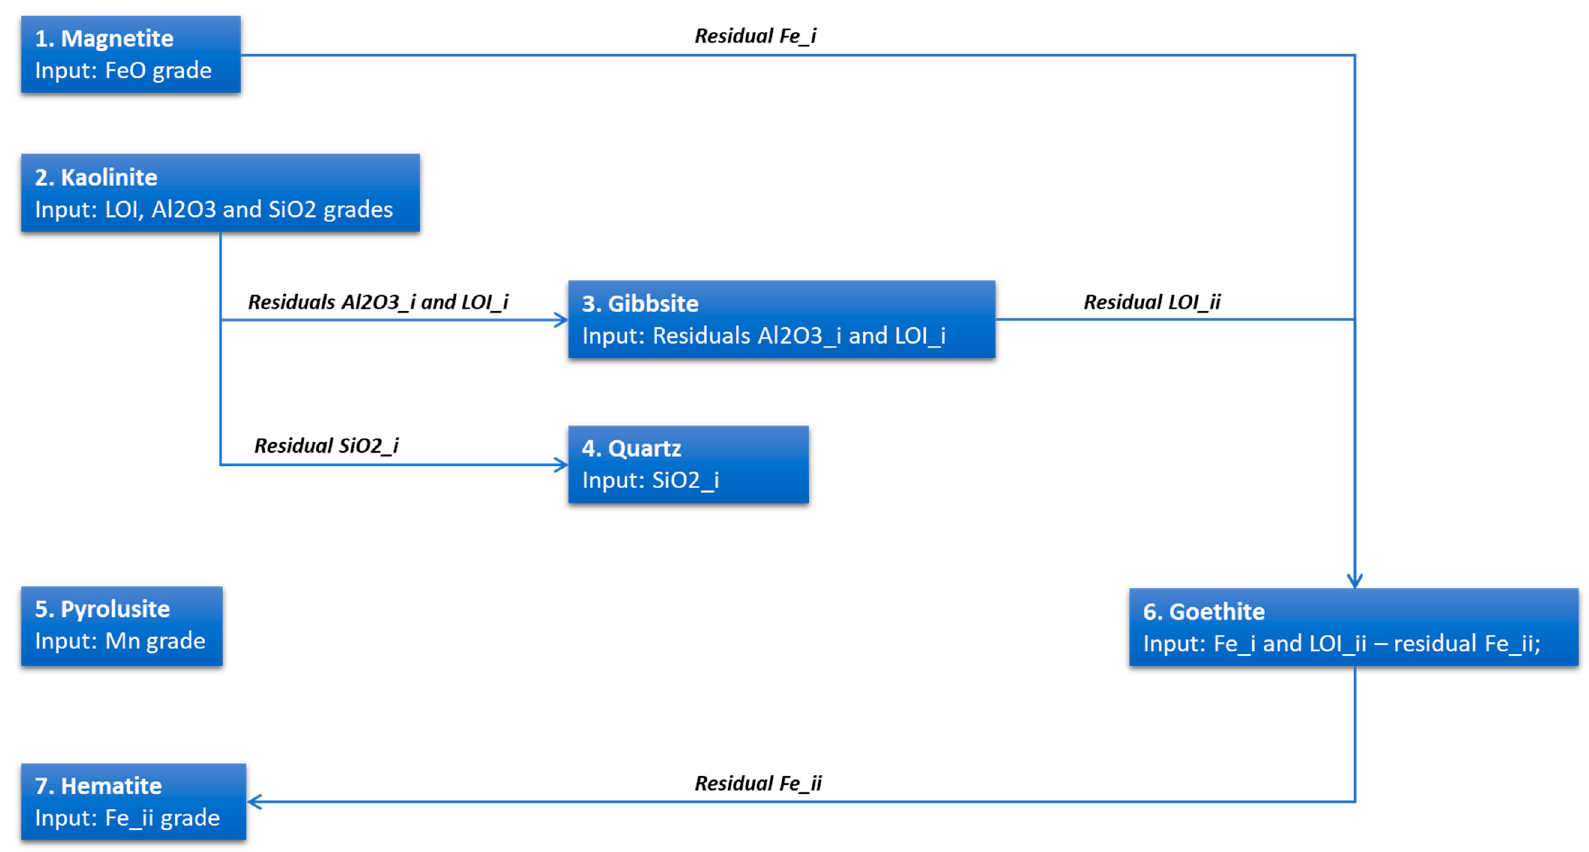
Figure A1. Flowchart of algorithm for weathered samples.